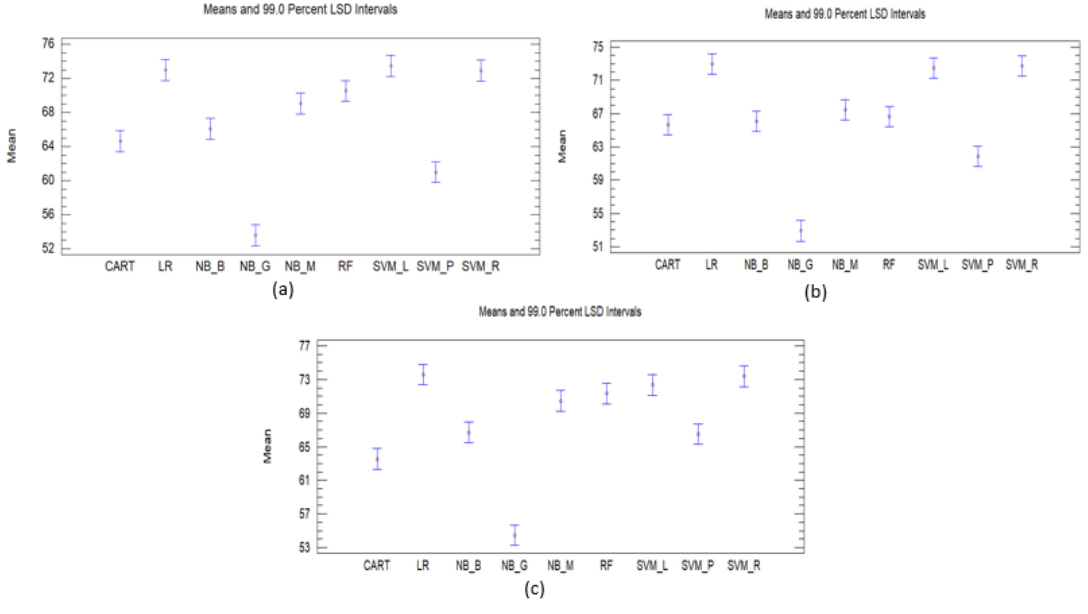
Figure 4. Box plot showing least significant difference (LSD) results on Nisha Madhulika’s dataset using ( a ) tf-idf, ( b ) count and ( c ) term frequency